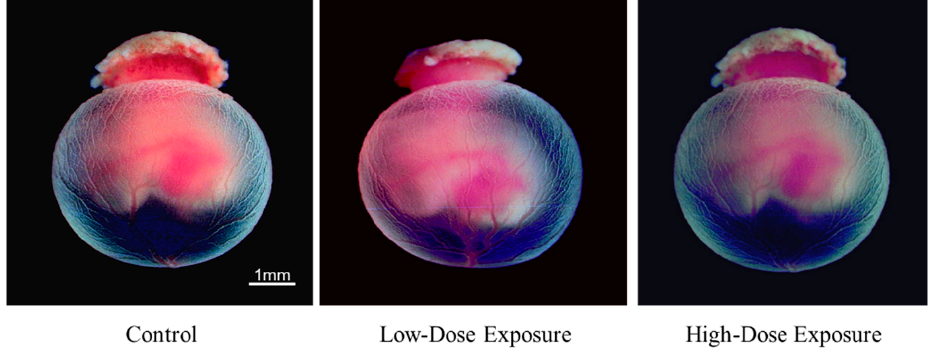
Figure 3. Morphological changes in rat embryos cultured for 24 h with low- and high-dose organohalogen contaminants from whale bacon. Whole cultured rat embryos with placenta and yolk sac. Scale bar = 1 mm.